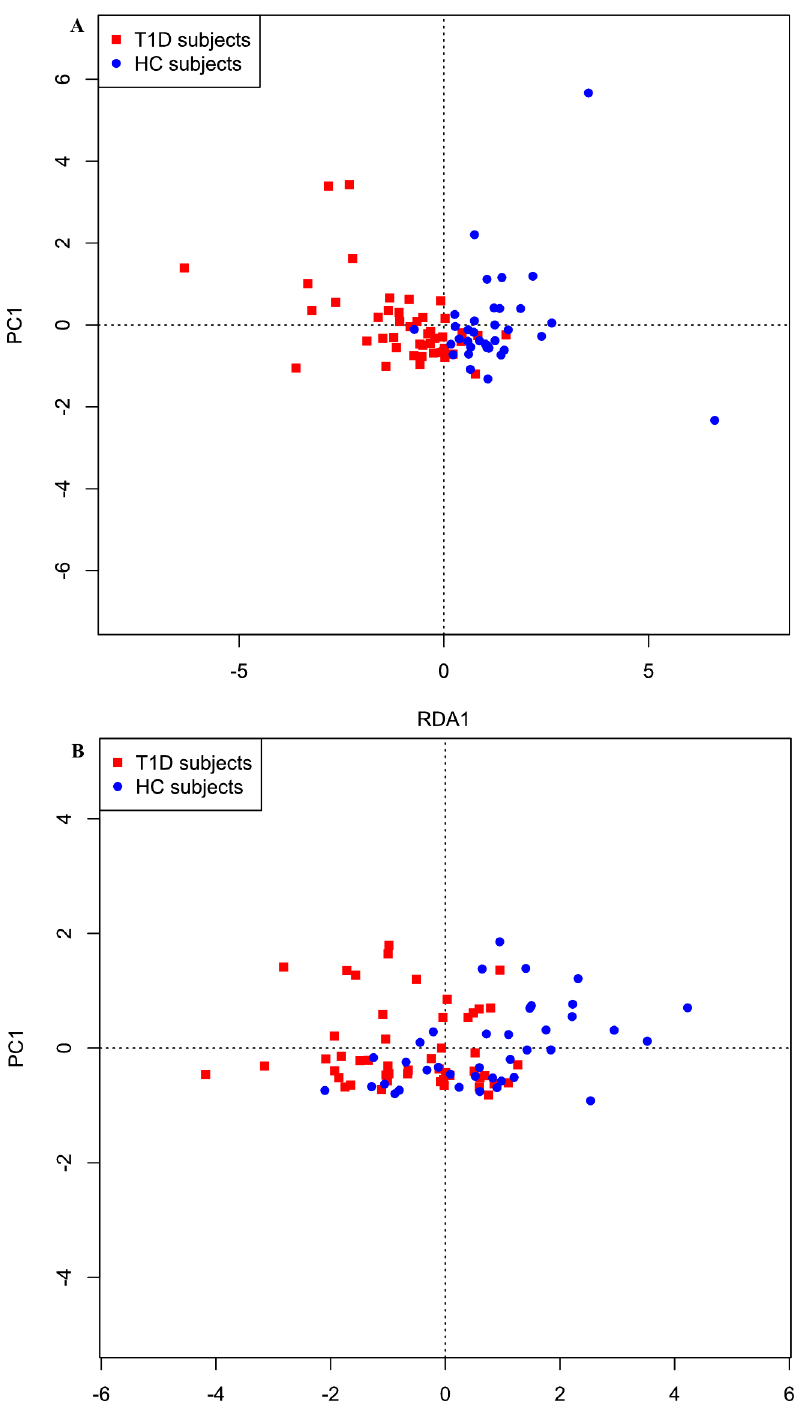
Fig 2. Fecal microbiota composition. Differencesin (A) fecal and (B) oral microbiotacompositionas depictedby a biplot of Redundancy Analysis (RDA axis 1 vs. axis 2) constrained by T1D or